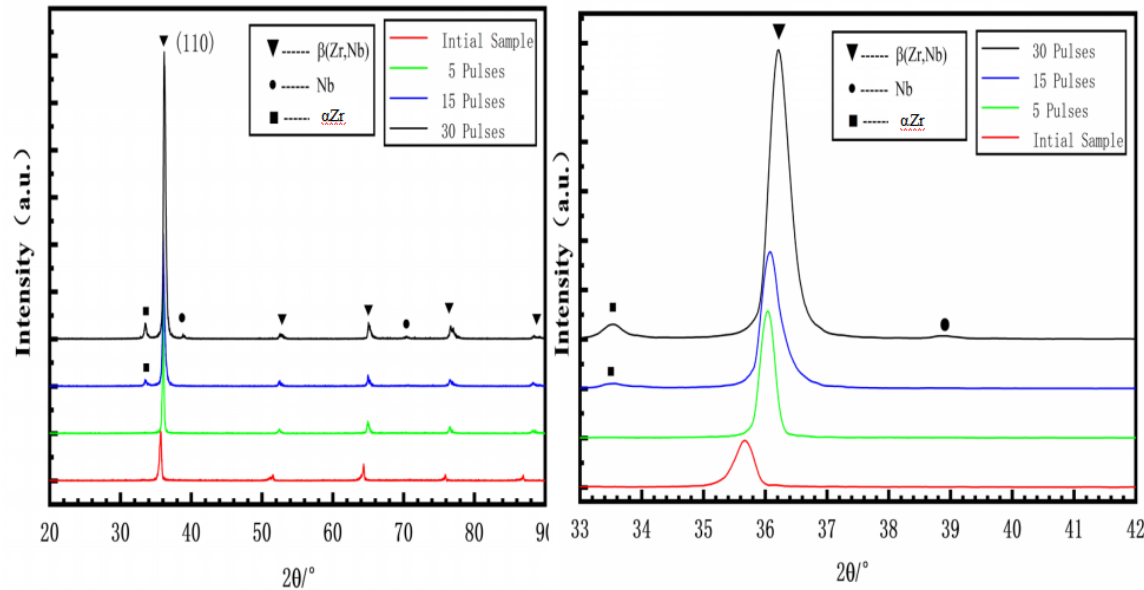
Figure 2: XRD patterns of Zr-17Nb alloy surface before and after HCPEB treatment Complete XRD pattern; (b) Enlargement of XRD pattern in